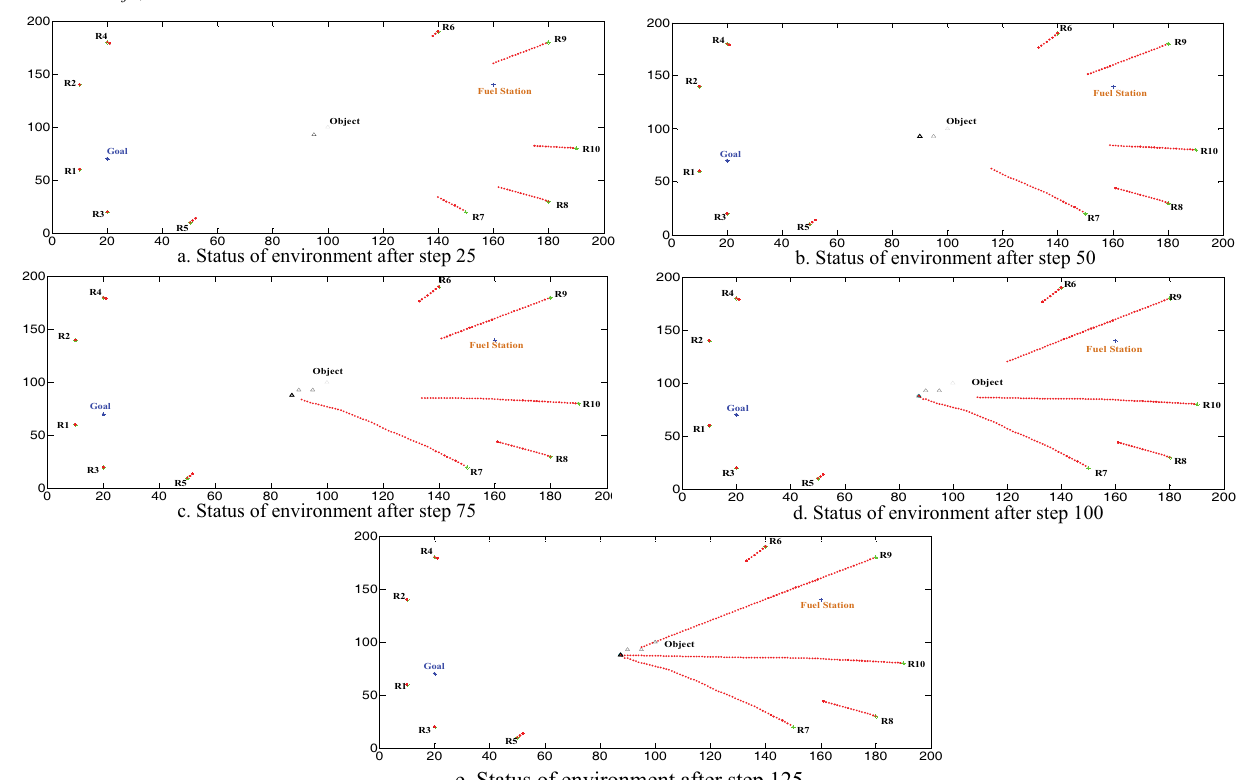
Fig. 8. Five snapshots of single-object foraging with random motion of the object.